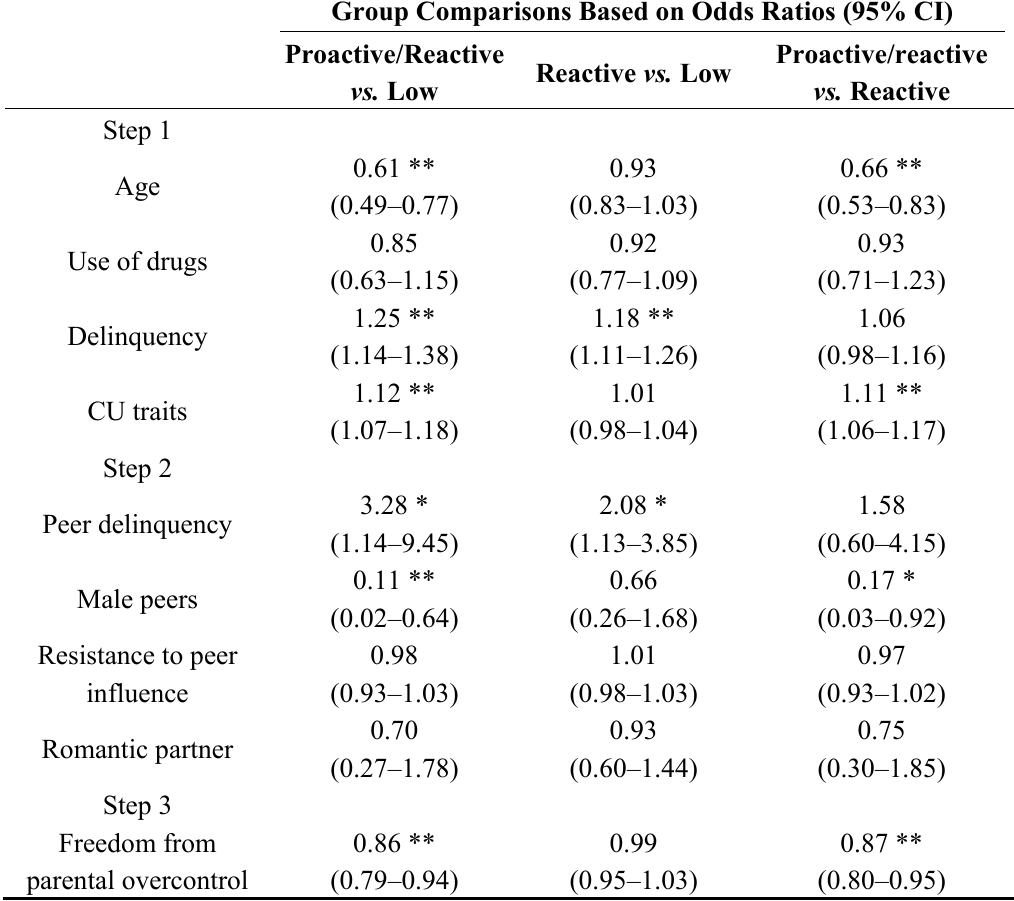
Table 3. Multinomial logistic regression